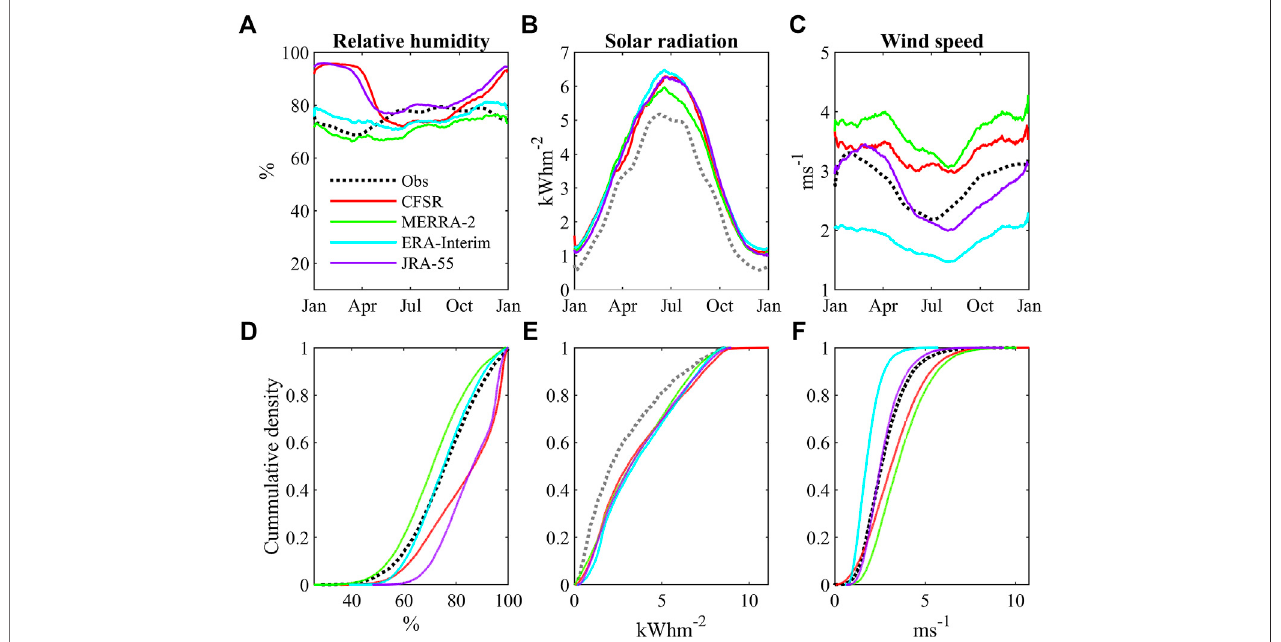
FIGURE3| Relative humidity,solarradiation, andwindspeedissuedbyCFRS,MERRA-2,ERA-InterimandJRA-55reanalysesover DuLoup catchmentbetween 1980 and 2009. First row presents daily mean annual cycles. Second row presents corresponding empirical cumulative distribution functions issued from daily values. Observations from neighboring meteorological stations (dashed black) and from For ˆ et Montmorency experimental site (dashed gray, 120 km) are given as a reference.